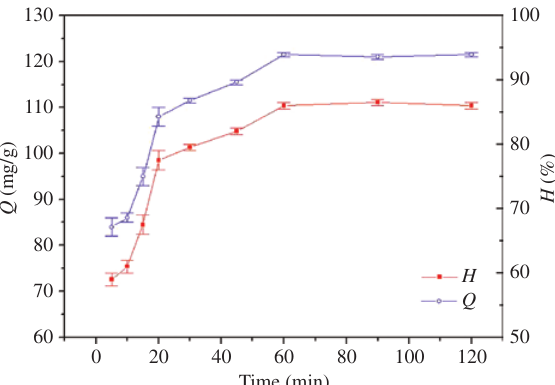
Figure 1: Variation of Cd 2 + adsorption capacity and efficiency of 0.1 g HAp according to the contact